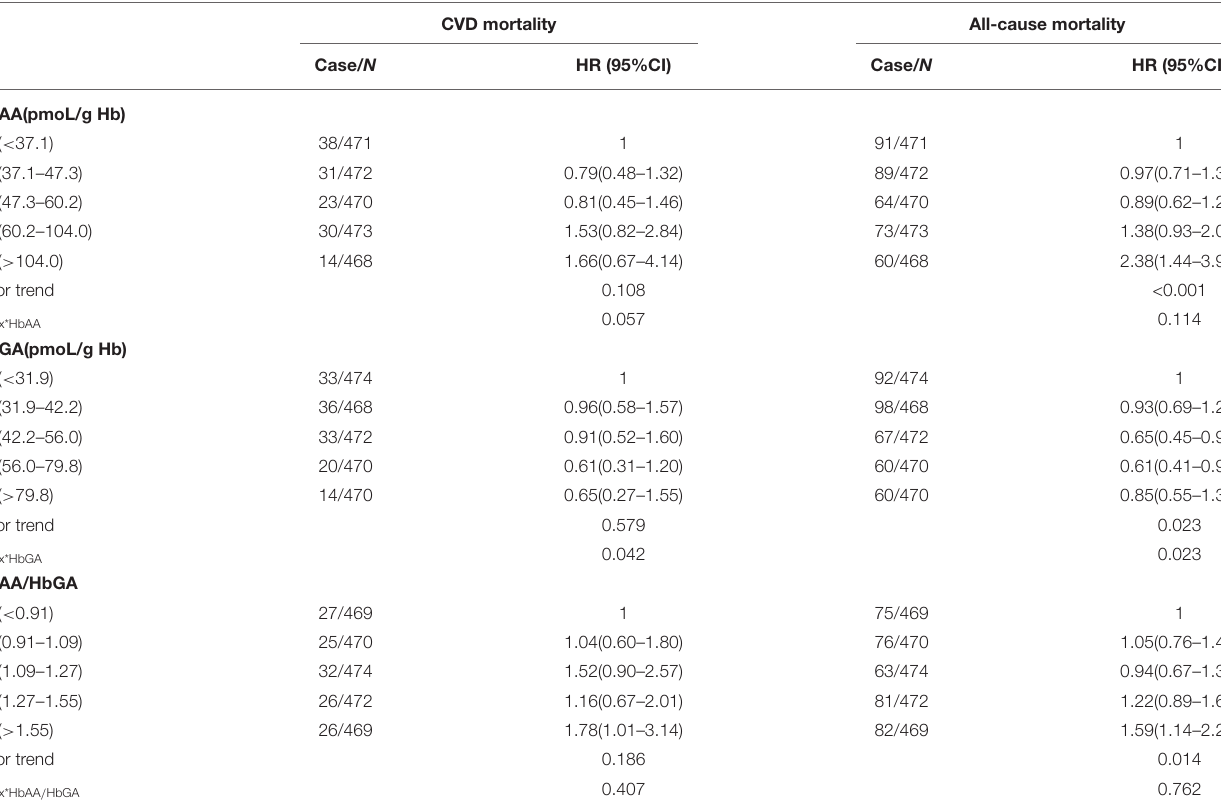
TABLE 4 | Adjusted HRs for the associations between HbAA, HbGA, HbAA/HbGA and CVD or all–cause mortality in pre-diabetes population. CVD